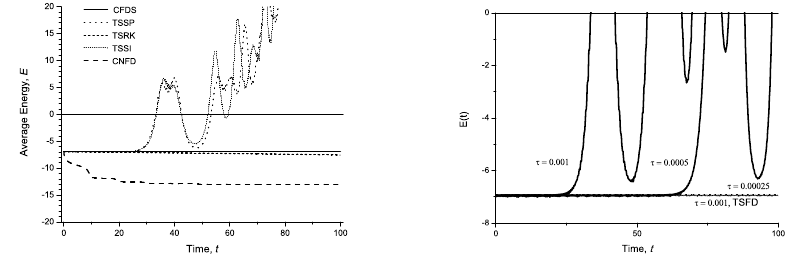
Figure 8. The energy of numerical solutions of GPE at g = − 25 obtained by different methods.